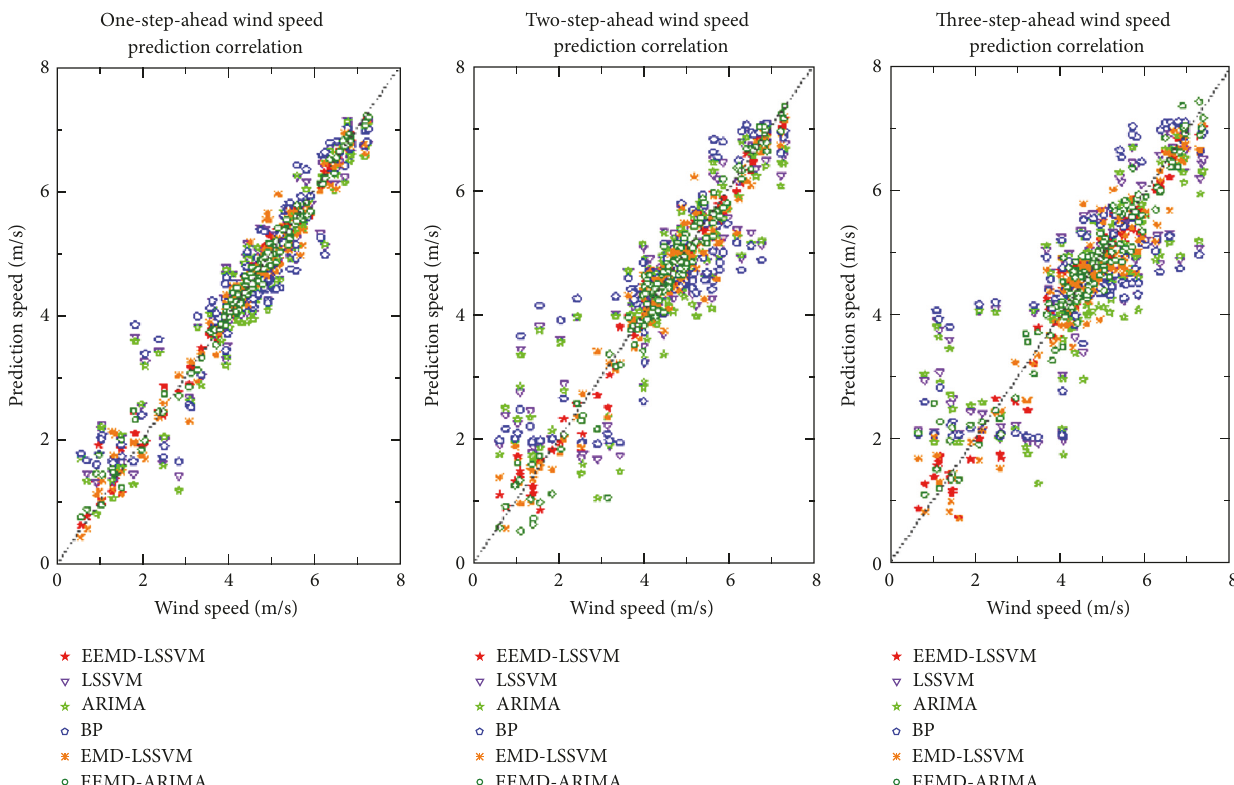
Figure 14: Scatter plots of prediction versus actual wind speed for different models (Case